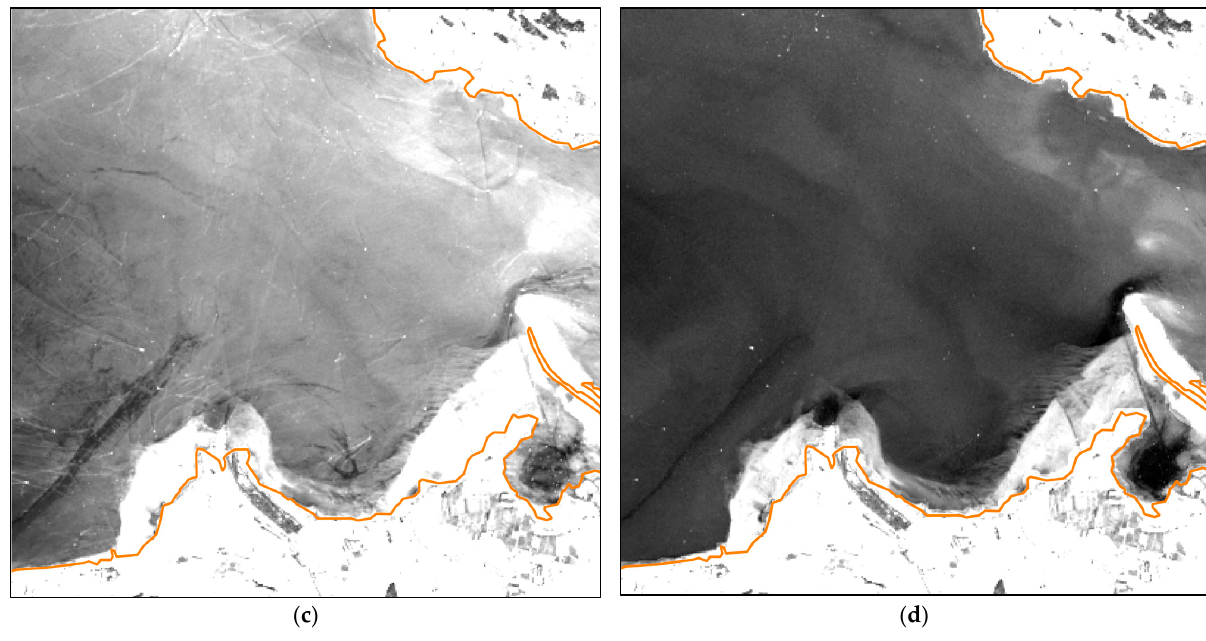
Figure A2. 12 × 12 km² subarea of sample scene LCE-2, Lake Constance East. ( a ) RGB image with glint; ( b ) RGB image glint corrected; ( c ) OLI B3 reflectance with glint; ( d ) OLI B3 reflectance, glint corrected. While LCE-2 is rather mildly glint contaminated, there are many small leisure boats not identified as bright objects which may have had a negative impact on GRCM. For example, the long dark diagonal structure in the lower left quadrant of ( d ) may constitute a correction artefact. Still, glint correction is deemed successful from visual inspection: dynamic processes in the water body (e.g., turbid plumes) can be clearly identified, the bathymetric features along the southern shore can be better delineated, and most of the boat wakes have been removed.